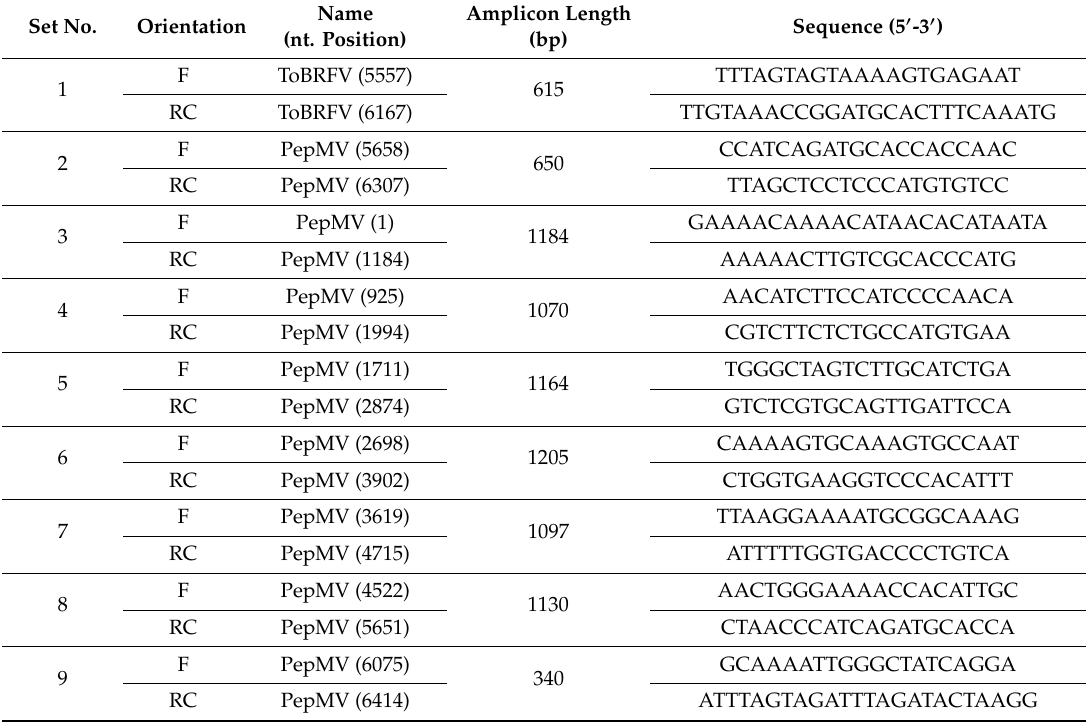
Table 1. Primer pairs served for tomato brown rugose fruit virus (ToBRFV) and pepino mosaic virus (PepMV) detection and PepMV whole-genome